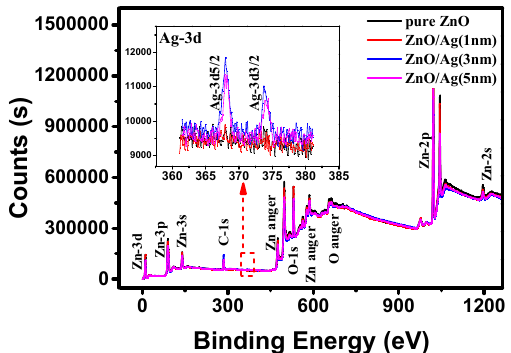
Figure 5. The XPS spectrum measured on the annealed ZnO films with different thicknesses of Ag layer.